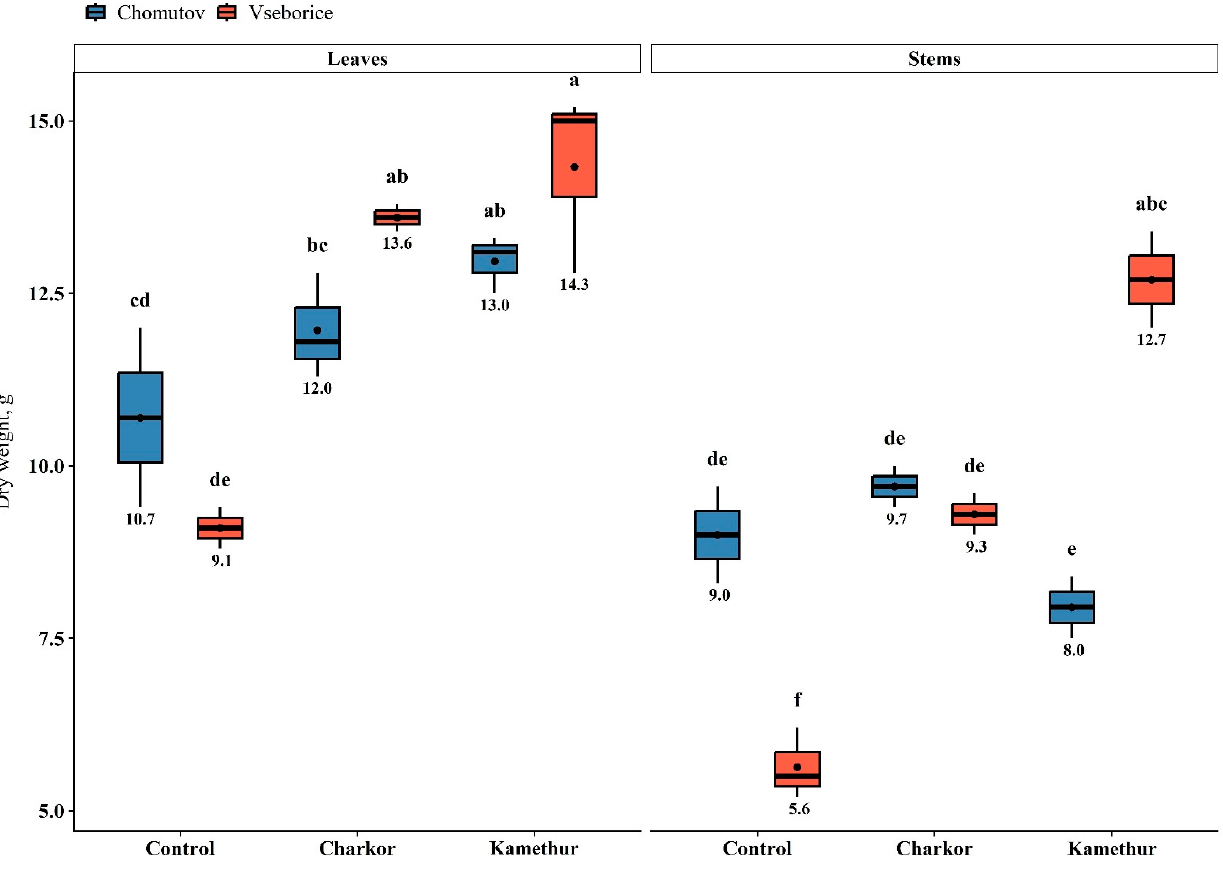
Figure 5. BCFs for M×g, as affected by the PGRs. L–leaves; S–stems. Different letters indicate a significant difference between the values ( p < 0.001). Thus, Kamethur positively affects leaf DW in both soils, and stem DW in more con- taminated soil (Všebo ř ice). The influence of Charkor was observed only for leaf DW in Všebo ř ice soil. 3.2. Impact of PGRs on Phytoremediation Parameters The concentration of the monitored elements in the plants’ tissues is presented in Table S3. The influence of PGRs on the M×g phytoremediation process was evaluated